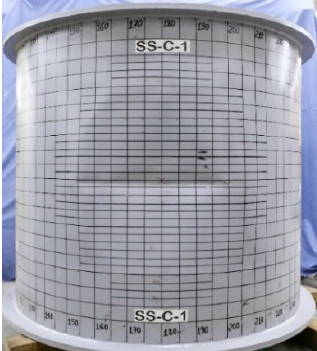
Figure 3. Numerical prediction compared with the test results.